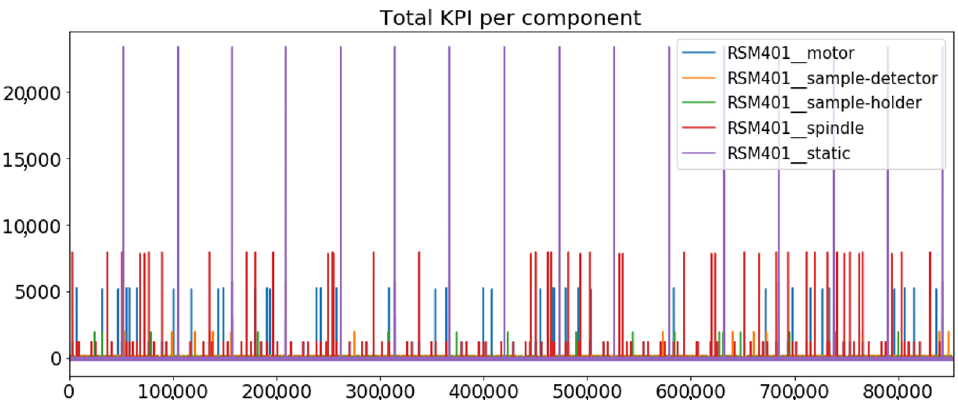
Figure 7. KPI time series for every component yielded from running the model for the friction welding machine (HWH). The simulation interval has the same length as for training (292 years).